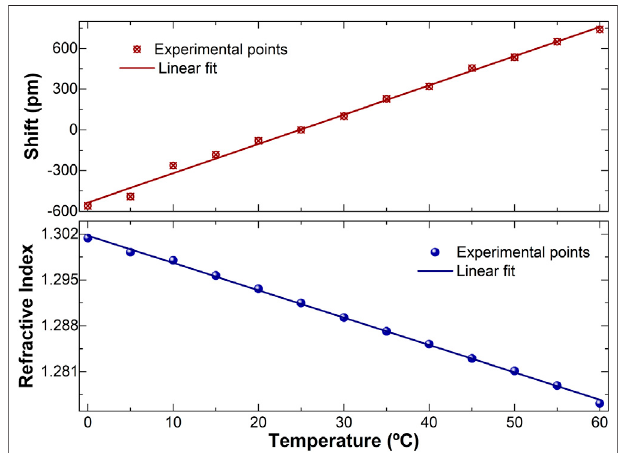
FIGURE 5 | Shift of the interference pattern (top graph) and refractive index as a function oftemperature (bottom graph) calculated from the spectra shown in Figure 4 . The experimental points of the bottom graph were calculated with Eq. 3